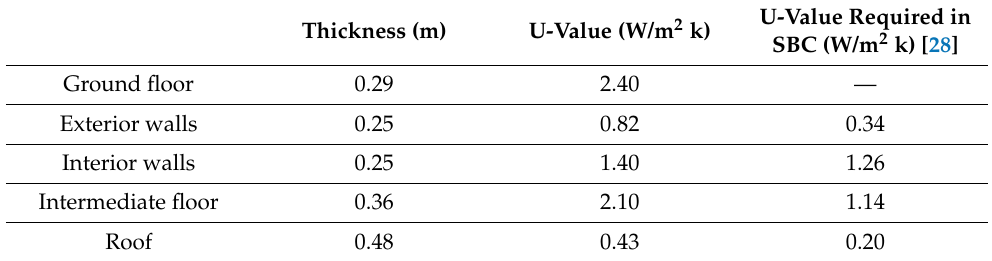
Figure 1. The residential building model: ( a ) external view; ( b ) satellite view; ( c ) ground floor; ( d ) first floor. Table 1. Specification of the thermal characteristics of building materials [27].